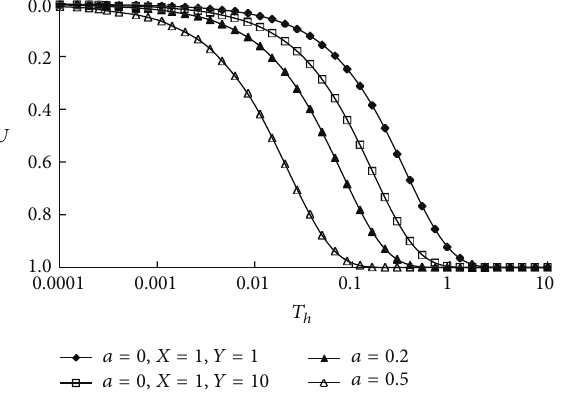
Figure 9: Influence of 𝑘 𝑠 / 𝑘 ℎ on consolidation